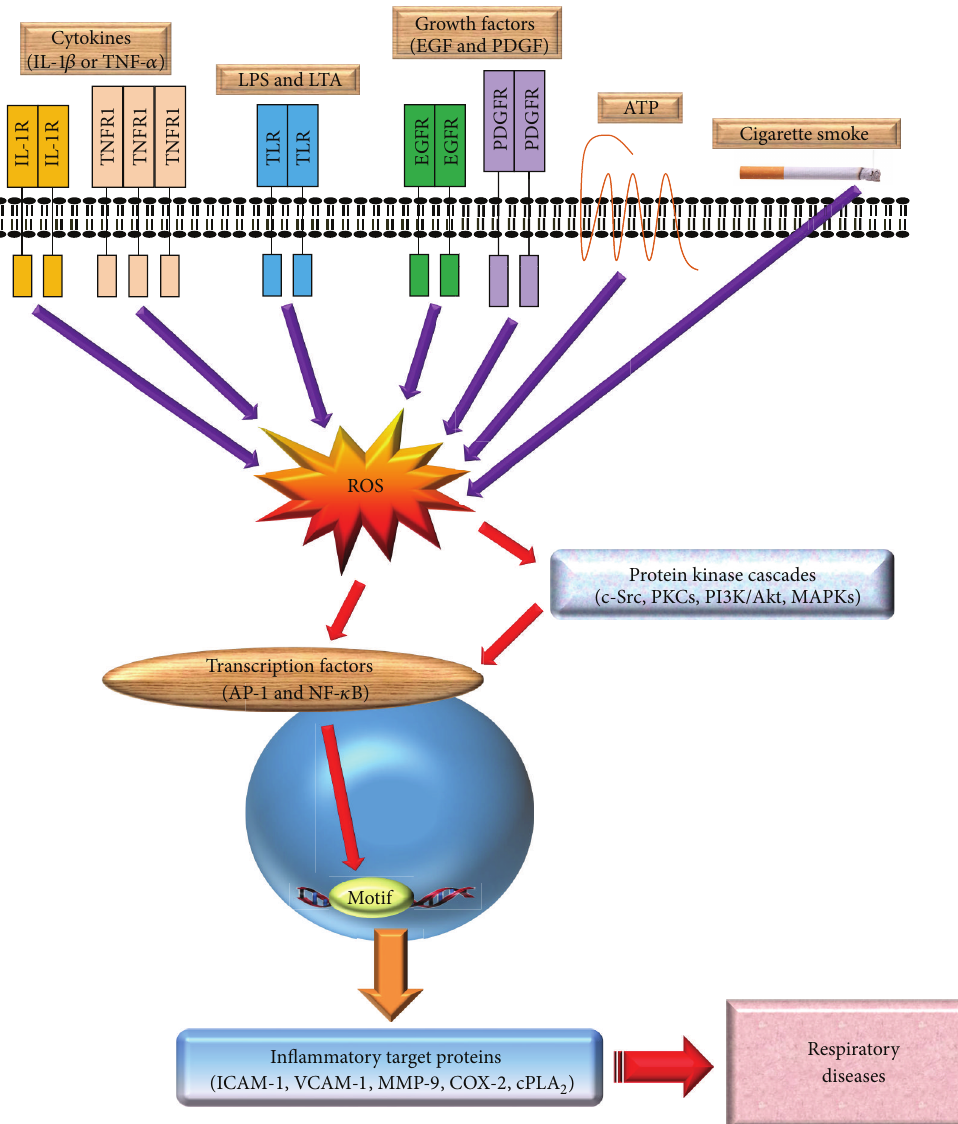
Figure 3: General overview of the inflammatory signaling pathways in respiratory diseases. Many of the known inflammatory target proteins, such as MMP-9, ICAM-1, VCAM-1, COX-2, and cPLA 2 , are associated with inflammatory signaling pathways induced by various stimuli, including TNF- 𝛼 , IL-1 𝛽 , ATP, cigarette smoke, LTA, or LPS. Moreover, the SFKs, PKCs, growth factor tyrosine kinase receptors, NADPH oxidase/ROS, PI3K/Akt, and MAPKs are components of signaling cascades that respond to extracellular stimuli by targeting transcription factors, such as NF- 𝜅 B and AP-1, resulting in the modulation of inflammatory gene expression associated with pulmonary